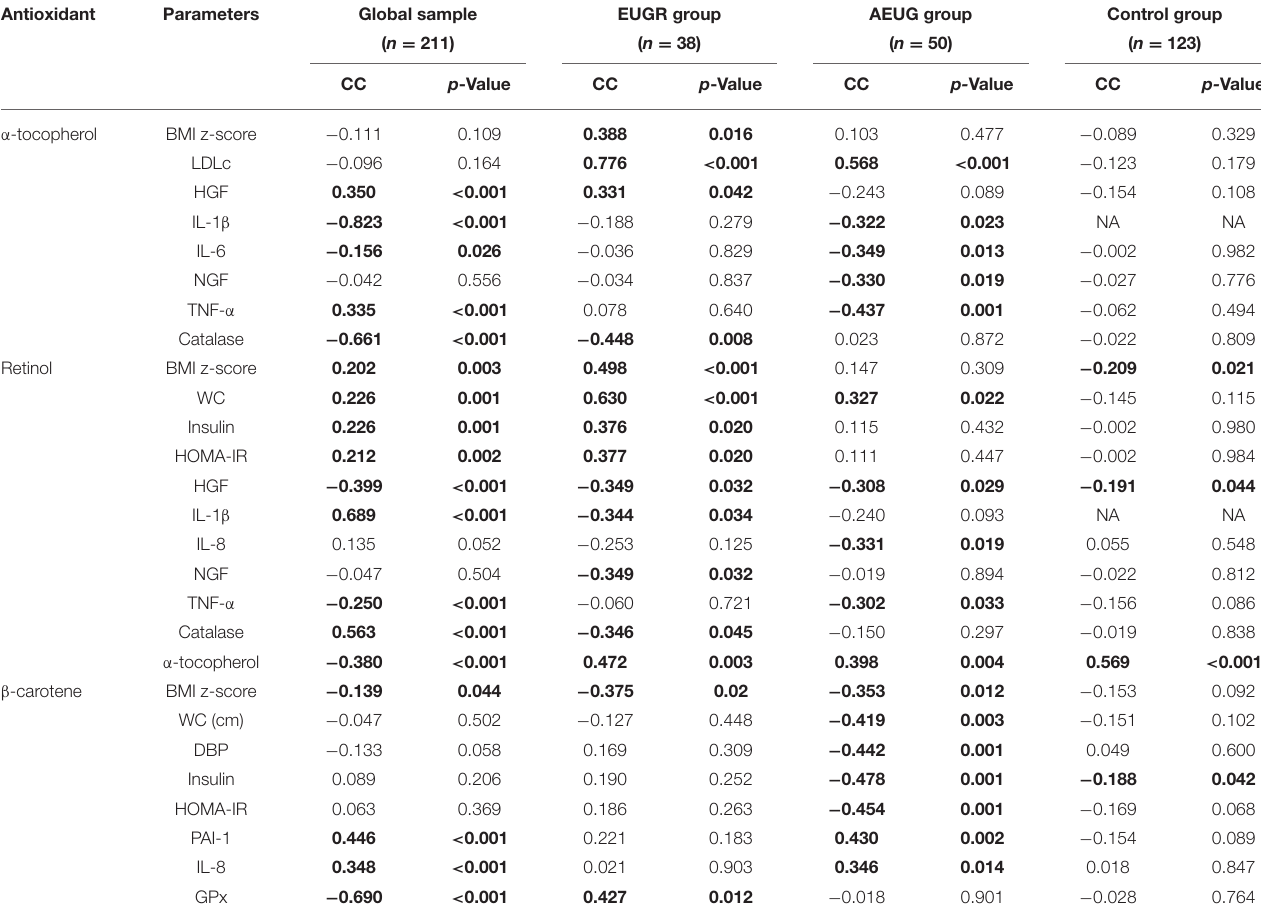
TABLE 5 | Selected significant relationships among plasma non-enzymatic antioxidants in the global sample and those in prepubertal children with a history of prematurity and extrauterine growth restriction (EUGR group), prematurity with adequate extrauterine growth (AEUG group), and healthy children (control group). Antioxidant